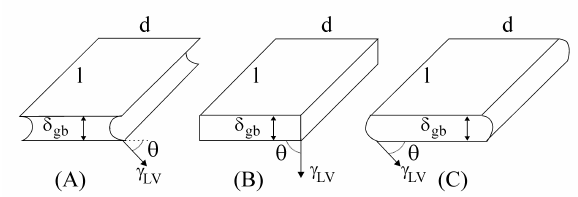
Figure 2. Two plane plates simulating two grains with a grain boundary liquid phase. A- Plates are kept apart by applied external forces; B- null external forces; C- compressing external forces.